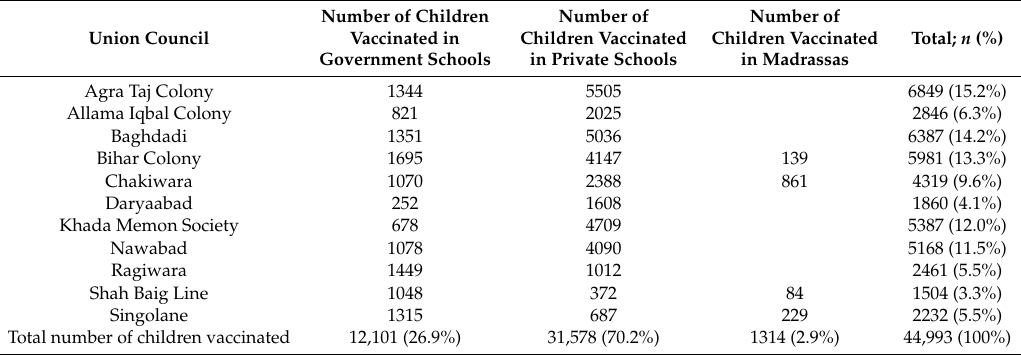
Table 1. Number of children vaccinated through the school-based vaccination campaign in Lyari Town. Union